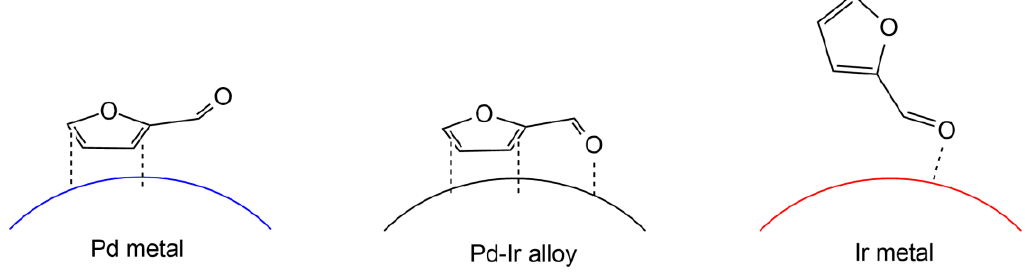
Figure 8. The proposed adsorption structure of furfural on the catalyst surface. Adapted from [83].